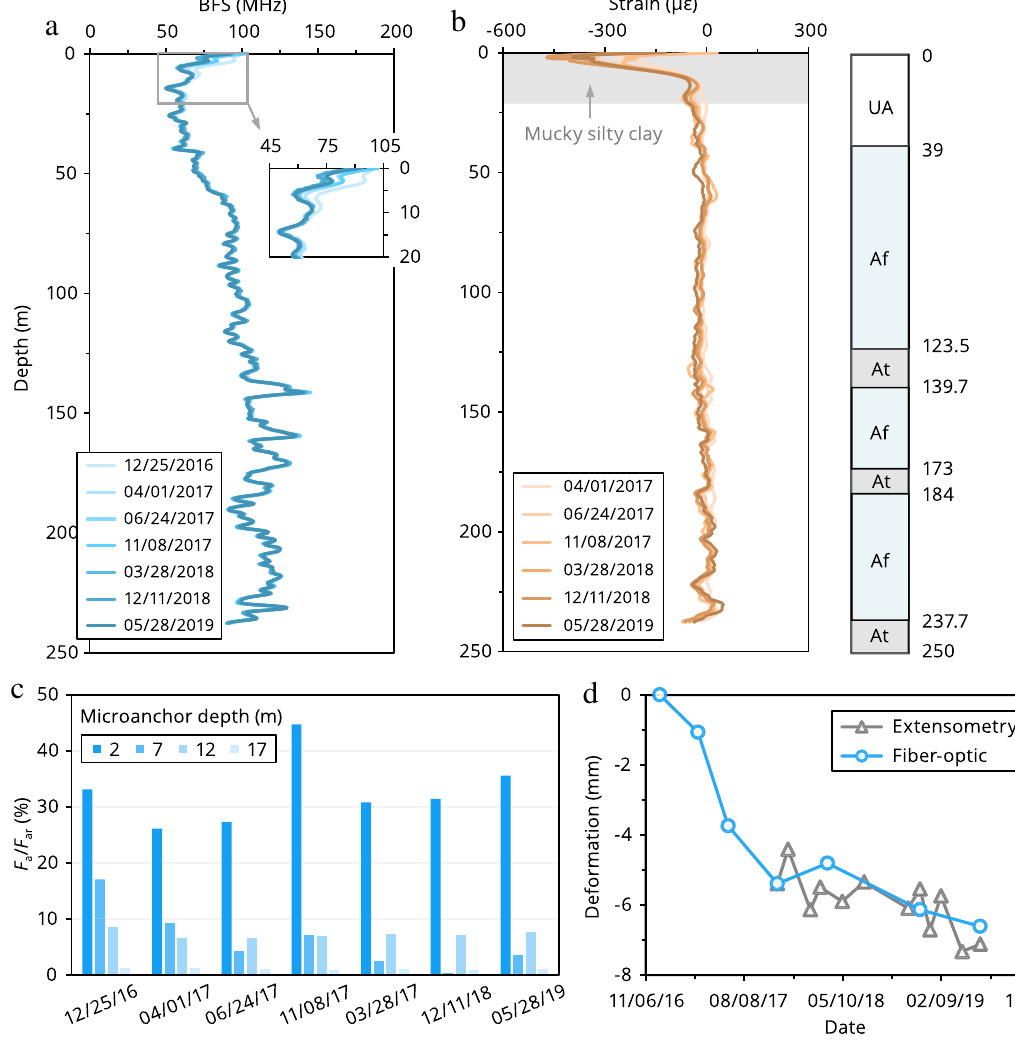
Figure 6. Microanchored fiber-optic DSS applied to a field experiment to monitor subsurface strata deformation in Yancheng (Jiangsu, China). ( a , b ) Fiber-optic data acquired with a cylinder-anchored cable in the Yancheng monitoring borehole from December 2016 to May 2019. ( a ) Original Brillouin frequency shift (BFS) profiles. ( b ) Derived strain profiles. UA: unconfined aquifer; Af: confined aquifer; At: aquitard. ( c ) Degree of mobilization of calculated ultimate soil–anchor interaction force F a / F ar at different depths. ( d ) Comparison between extensometer measurements and fiber optically determined deformation at 0–240 m